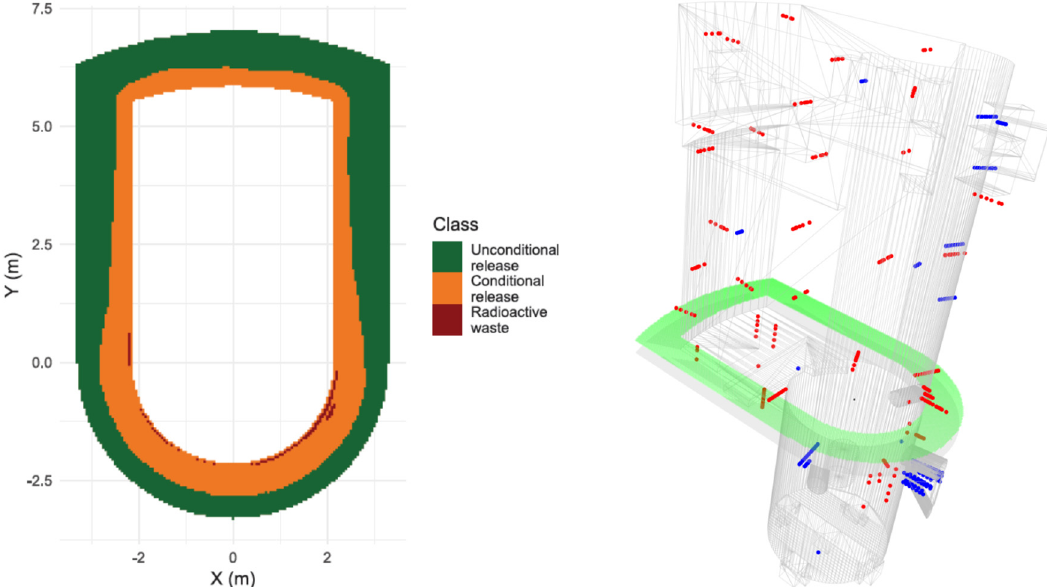
Fig. 6. Example of a horizontal slice of the BR3 biological shield indicating the forecasted classes and the corresponding 3D location (left; data for z = 0.5m, right; existing primary data points are shown in blue, new primary data points in red and the location of the slice at a reference height of 0.5 m is marked in